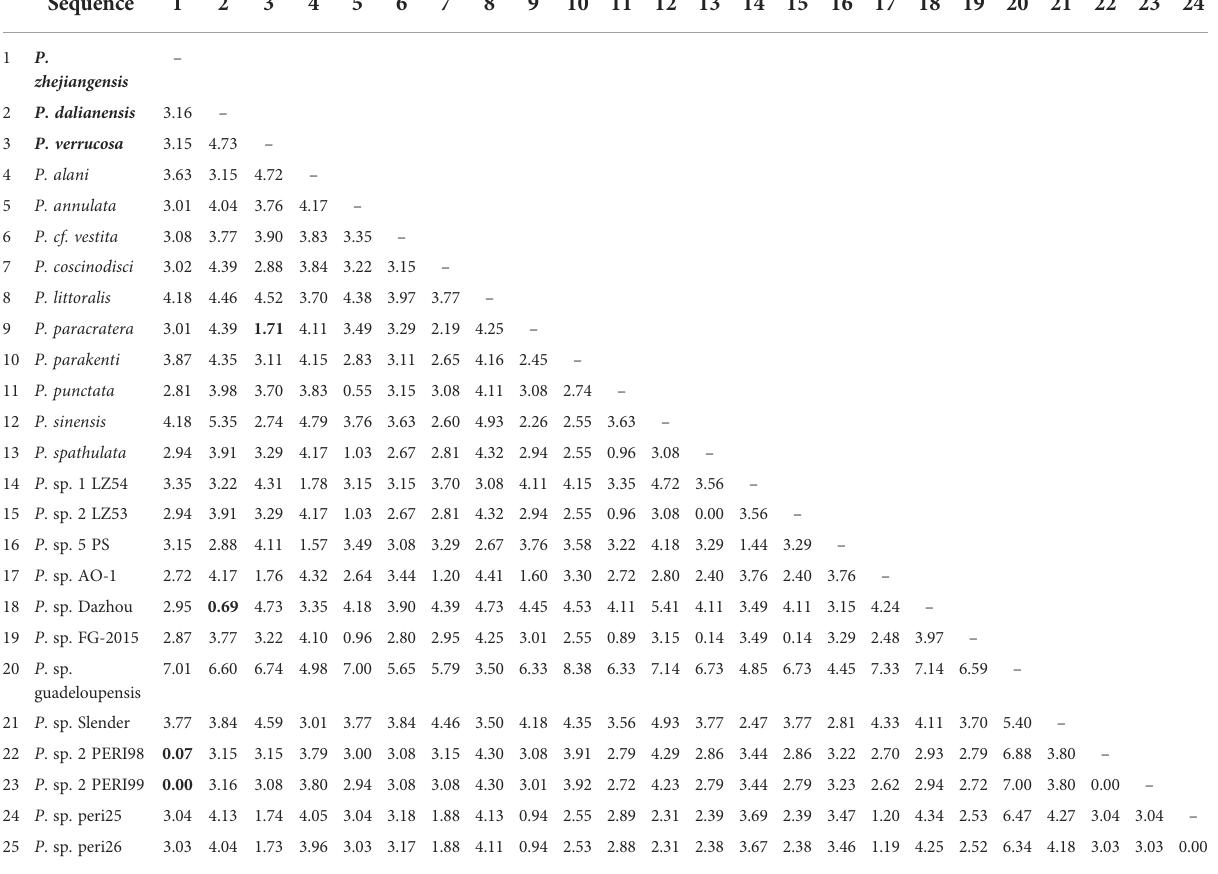
TABLE 2 Genetic distances among SSU rDNA sequences of Pseudovorticella species in group B in the phylogenetic tree.